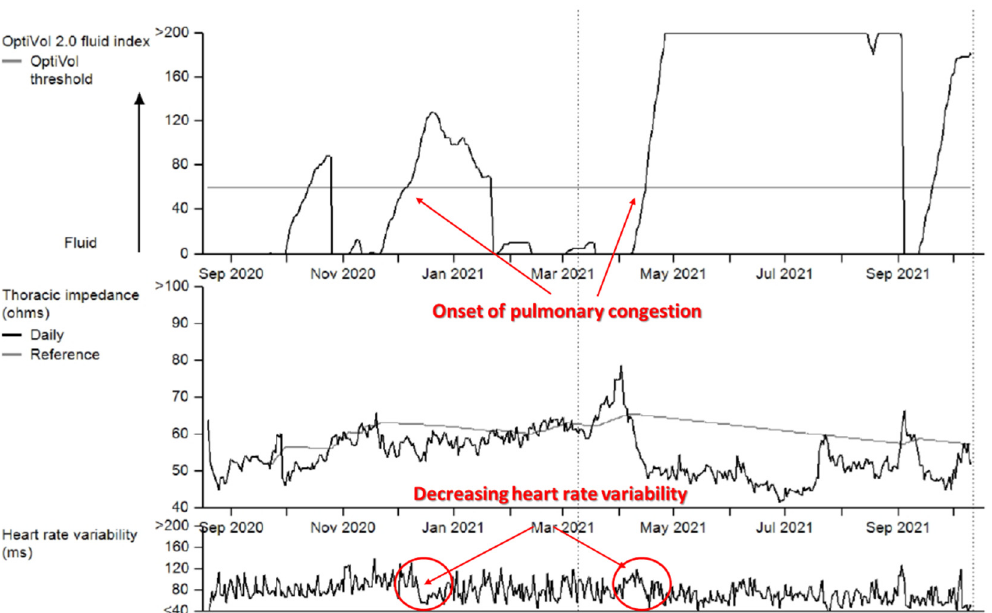
Figure 5. Long term heart rate variability in a patient with a Medtronic implanted biventricular defibrillator (cardiac resynchronization device implanted in patients with severe cardiomyopathy and ventricular dyssynchrony). The device continuously records heart rate and heart rate variability data. In addition, thoracic impedance is measured, which correlates with the degree of pulmonary congestion and severity of heart failure symptoms. Sudden decrease in heart rate variability may be observed at the onset of increasing pulmonary congestion (decreased thoracic impedance due to fluid buildup). As these findings may precede the onset of symptoms by several days, remote monitoring may identify high risk patients for targeted intervention.